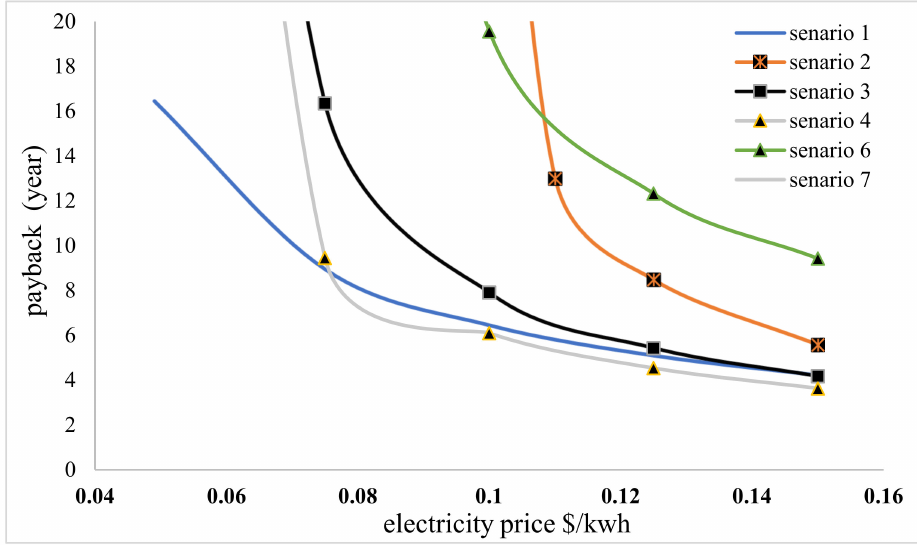
Figure 8. Payback period changes based on the selling price of